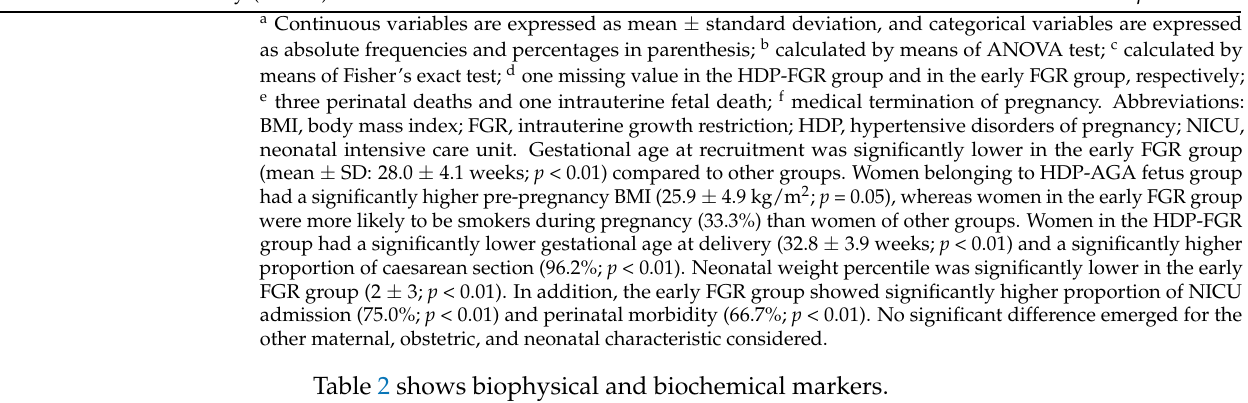
Table 2 shows biophysical and biochemical markers. Table 2. Biophysical and biochemical markers a according to pregnancy complication groups and controls.